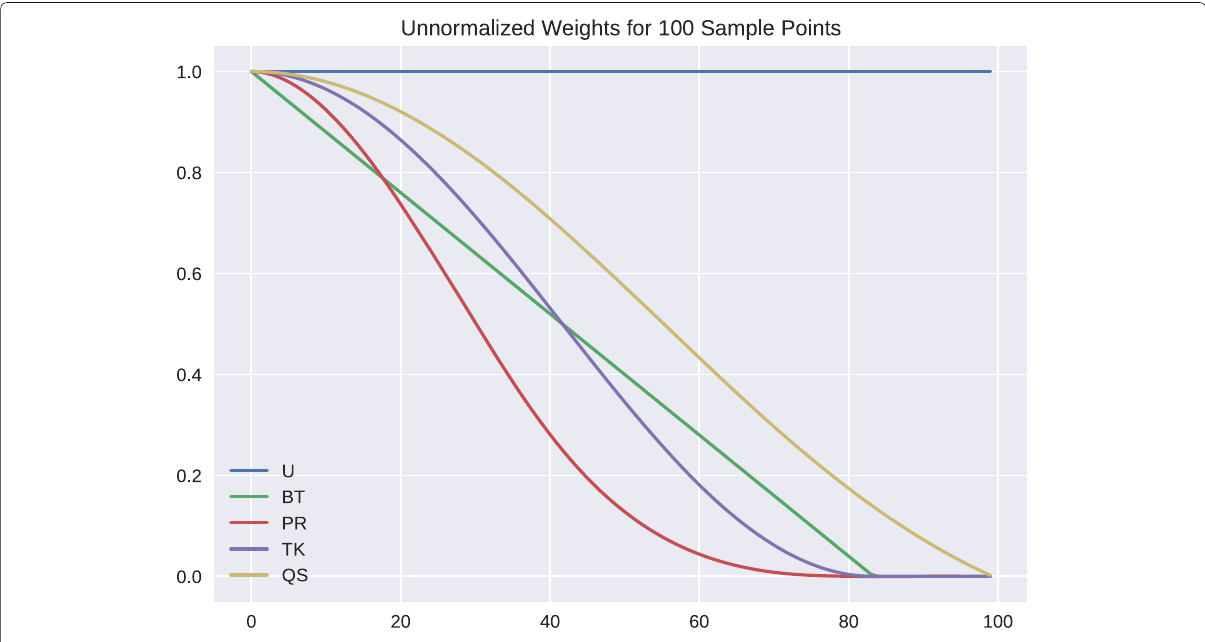
Fig. 1 Plot of the unnormalized HAC kernel functions k BT , k PR , k TK , k QS and the uniform